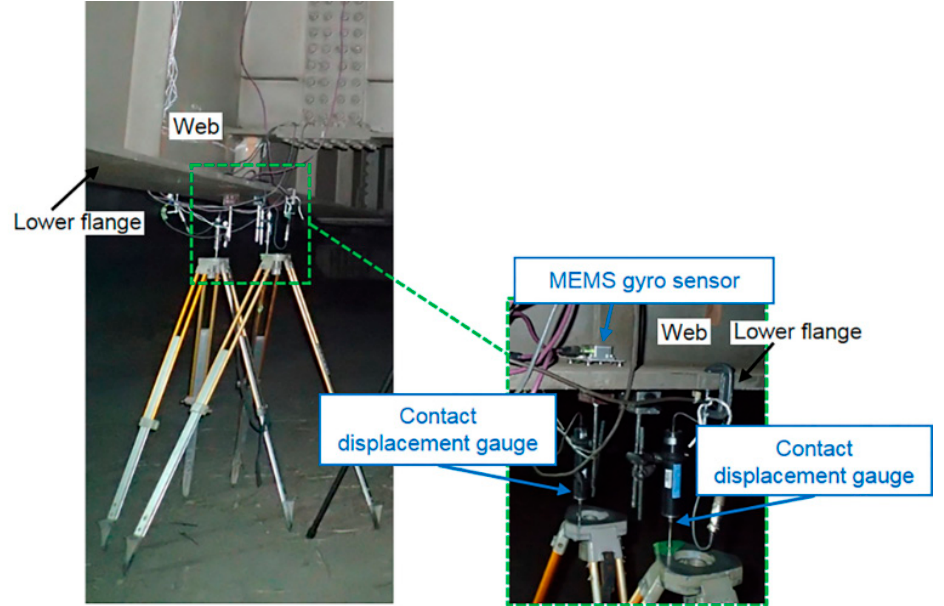
Figure 4. Installation of micro-electro-mechanical system (MEMS) inertial measurement unit (IMU) and two contact displacement gauges.